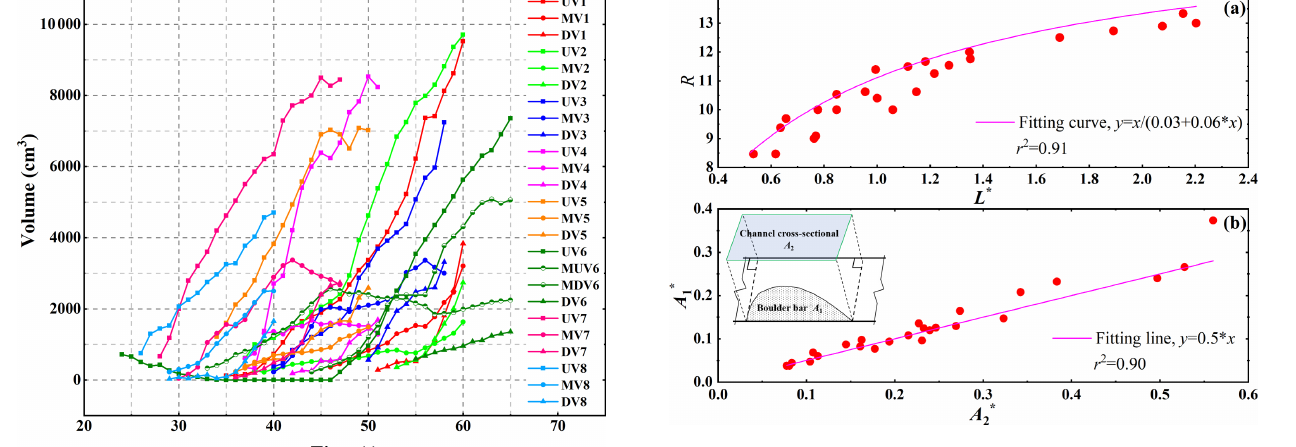
Figure 8. Geometry characteristics of boulder bars after the dam failed in the experiments. (a) The relationship between length to width ratio ( R ) and dimensionless length ( L ∗ ); (b) the relation- ship between a boulder bar’s dimensionless area ( A ∗ ) and the cross- 1 sectional dimensionless area of the river channel along the boulder bar ( A ∗ 2